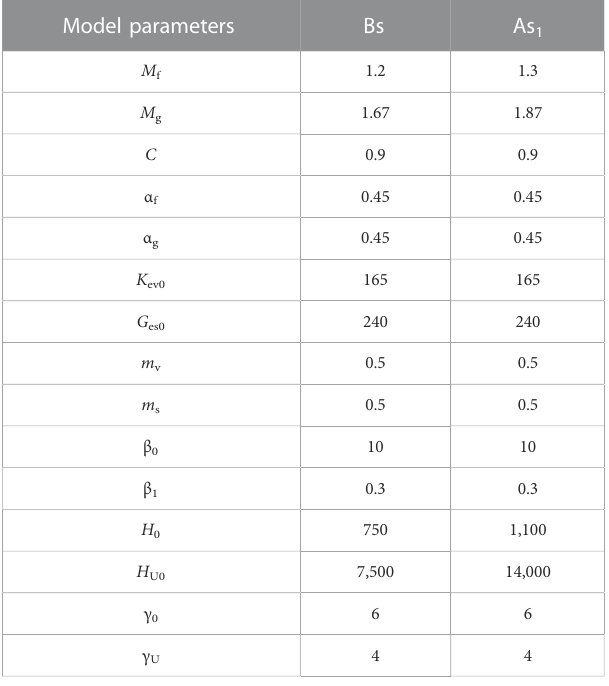
TABLE 3 Parameters of Pastor – Zienkiewicz III model for Bs and As 1 layers. Model